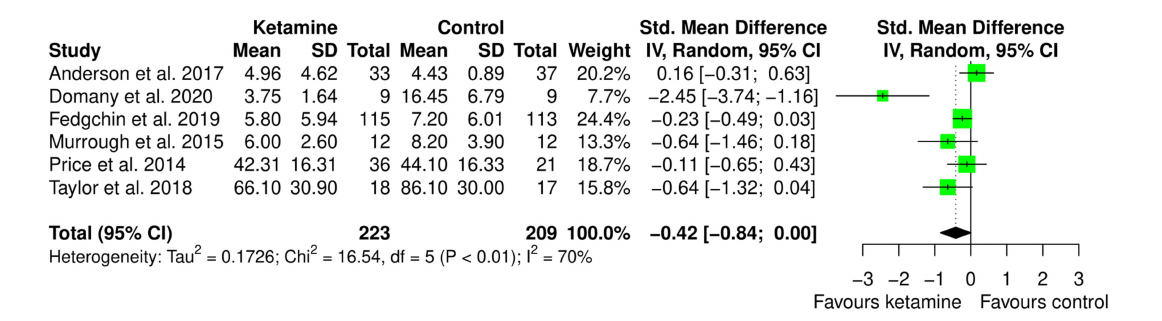
FIGURE5 Forest plots of anxiety among ketamine/esketamine and control groups. SD, standard deviation; IV, inverse variance; 95% CI, 95% confidence interval. x axis labels have been edited according to the characteristics of the outcome: since lower scores indicate less anxiety the label “Favors ketamine” is on the left-hand